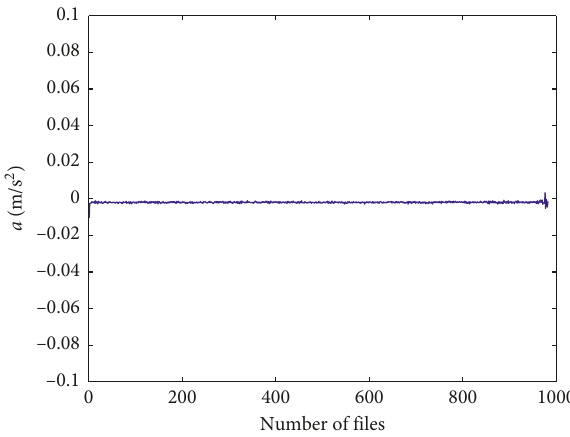
Figure 2: The mean value of the whole life of Case